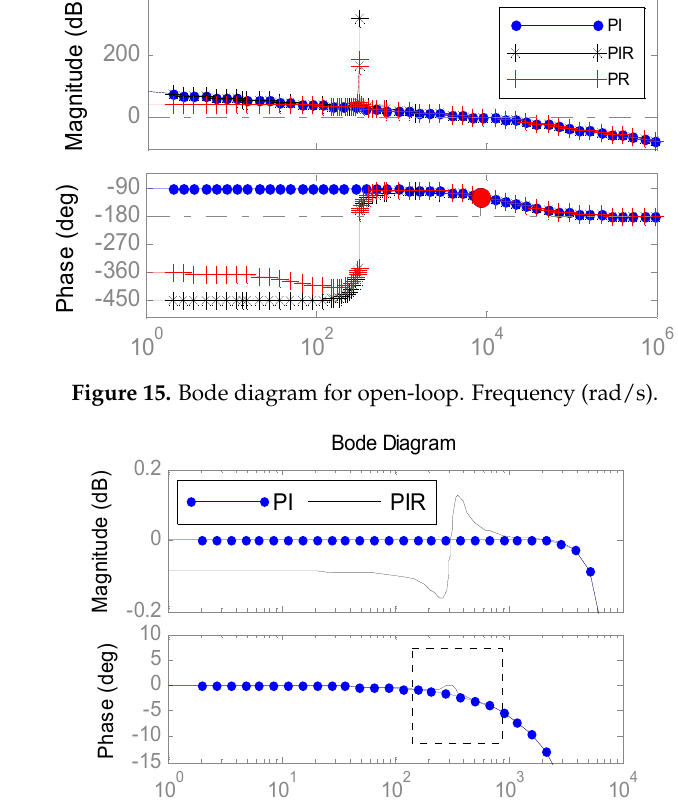
Figure 16. Bode diagram for closed-loop. Frequency (rad/s).